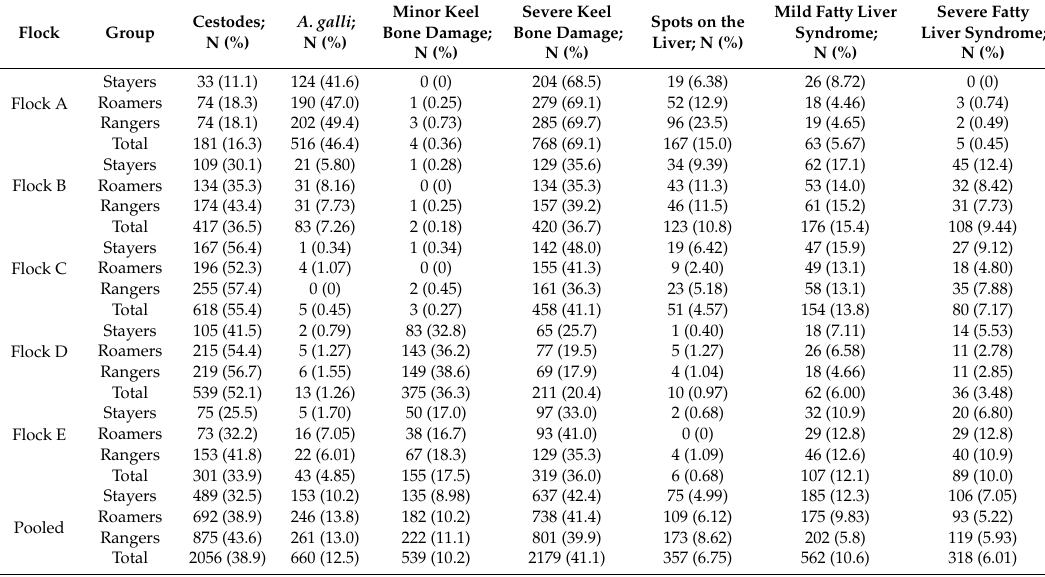
Figure 1. The survival analysis using the Kaplan-Meier estimates for 5 flocks of stayers, roamers and rangers. Censoring is indicated by the horizontal line tic mark. Table 3. Descriptives of the total number of hens (N) and the proportion of hens (%) with keel bone damage, cestodes, A. galli infection, spots on the liver and Fatty Liver Syndrome observed in stayers, roamers and